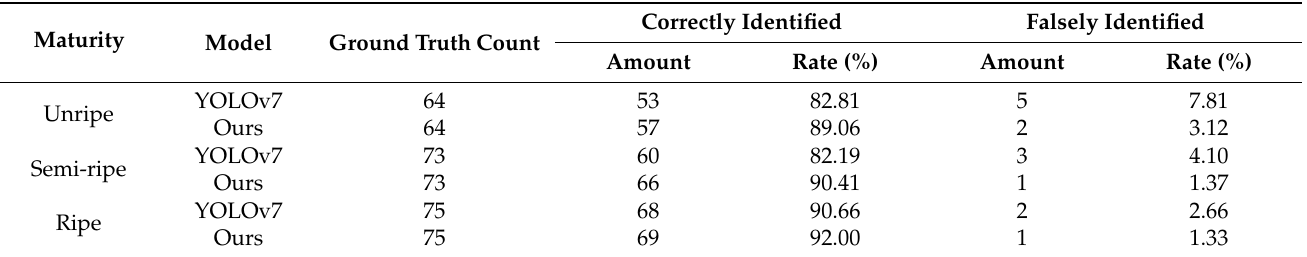
Table 5. The comparison results of the proposed model and YOLOv7 in detecting pineapple under different